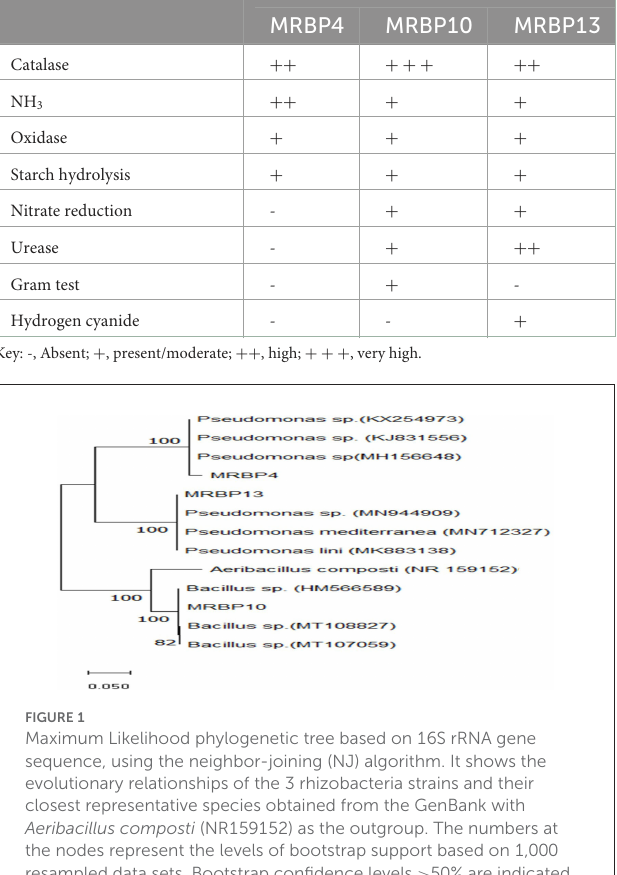
TABLE 1 Biochemical features of rhizobacteria strains. Biochemical features